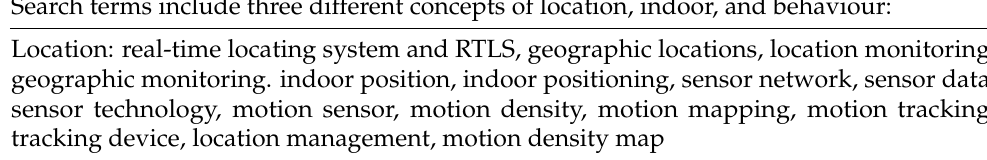
Table 1. Search term concepts used within the Scopus